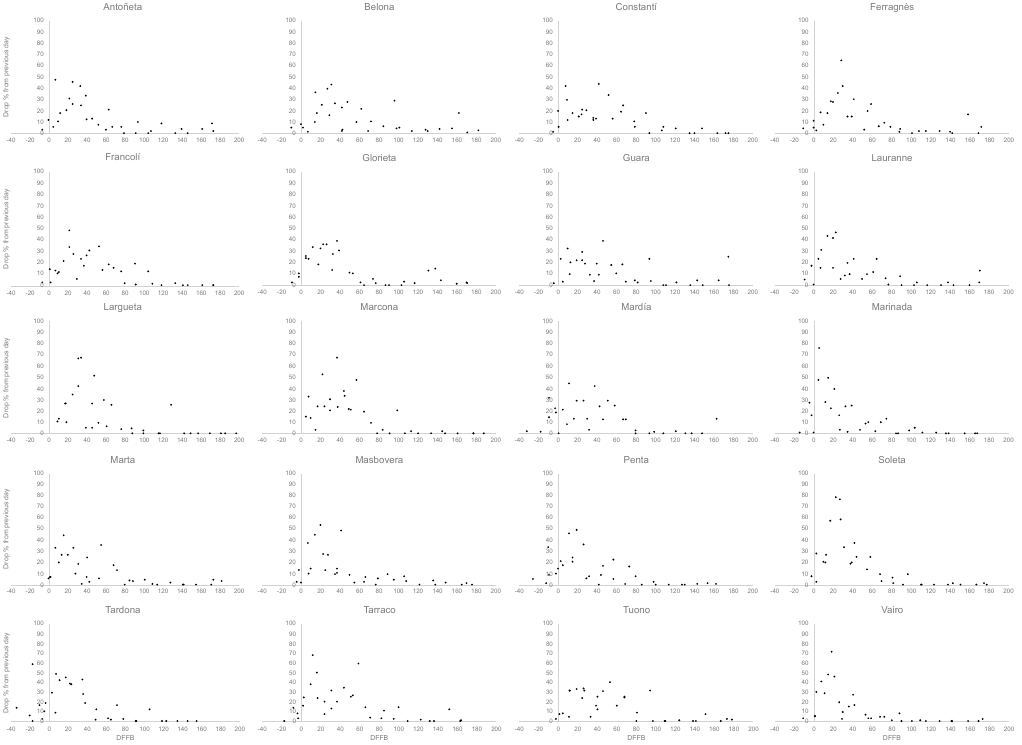
Figure 2. Fruit drop percentage from previous day for twenty different almond cultivars along days from full bloom (DFFB) at Les Borges Blanques, Spain (P1). Each dot represents the average of eight trees and one branch/tree. Data was recorded during 2015–2017.